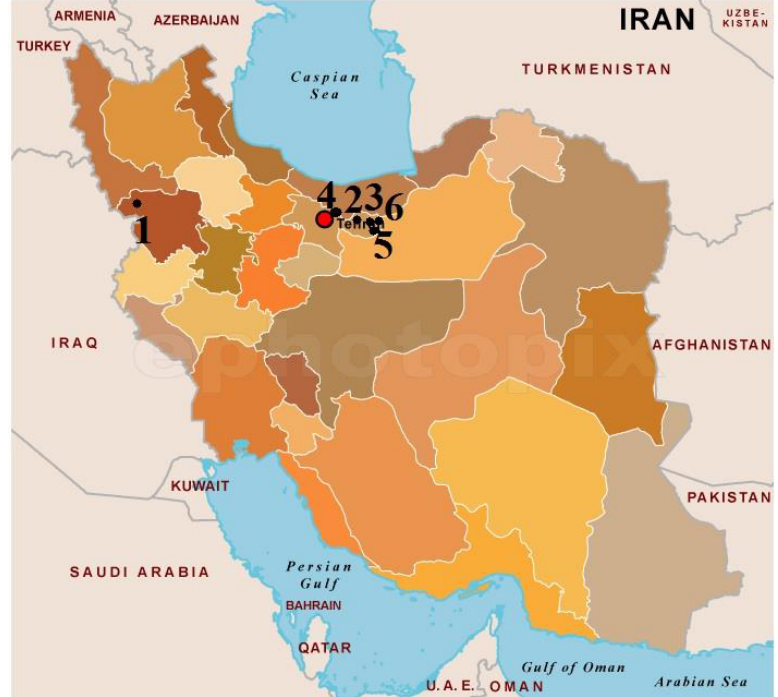
Fig.1. Distribution map of L. peltata populations.